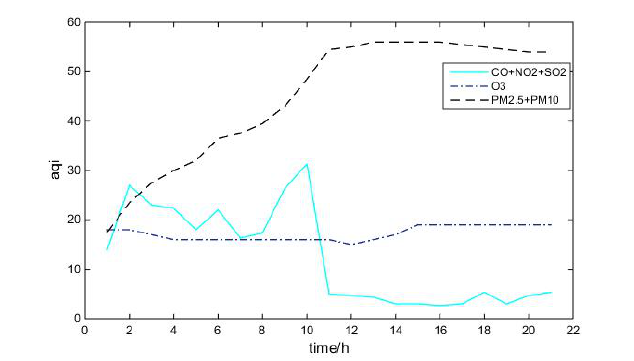
Fig. 3. Trends of the mean IAQI, data collected at observation station #2, on Dec.10th,